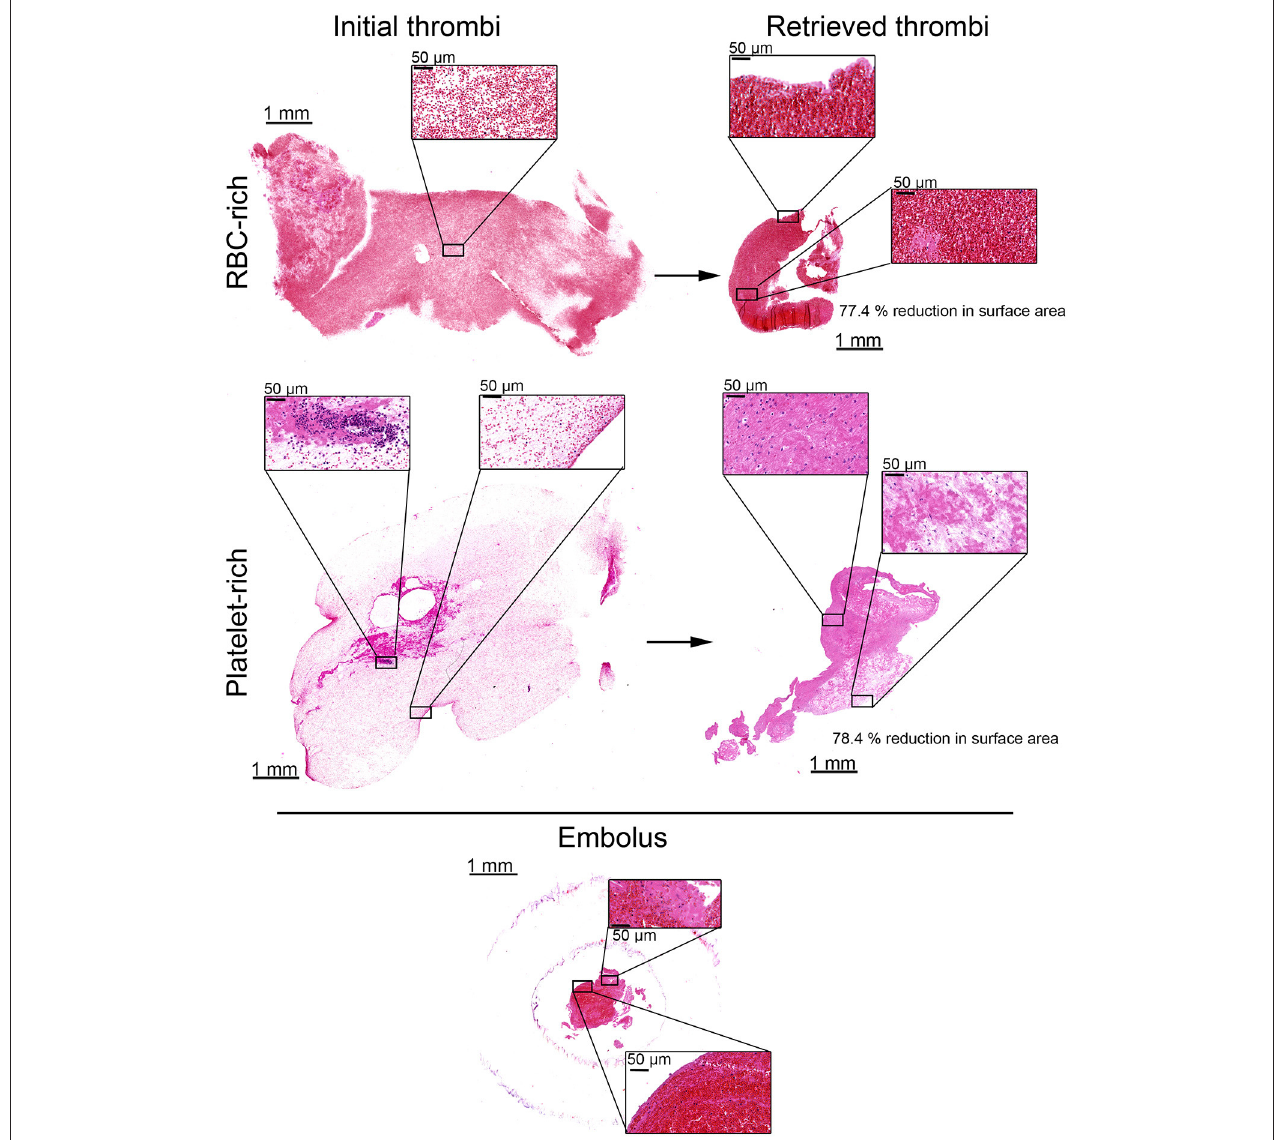
FIGURE 4 | Histological aspect of red blood cell-rich and platelet-rich thrombi before and after injection in the simulation system and EVT procedure. Representative images of hematoxylin and eosin (H and E) stained red blood cell (RBC)-rich (upper panels) and platelet-rich (middle panels) thrombi before being injected into the simulation system (left panels), and after their recovery by EVT (right panels). Insets show higher magnification images of the squared areas. Note that both types of retrieved thrombi are drastically compacted as shown by their reduced size and higher cell density as compared to initial thrombi. The lower panels show H and E images of the RBC-rich thrombus responsible for large vessel occlusion in the intracranial cartridge. Insets show higher magnification images of the squared areas. Note the compaction of thrombus components in both RBC-poor (upper inset) and RBC-rich (lower inset)